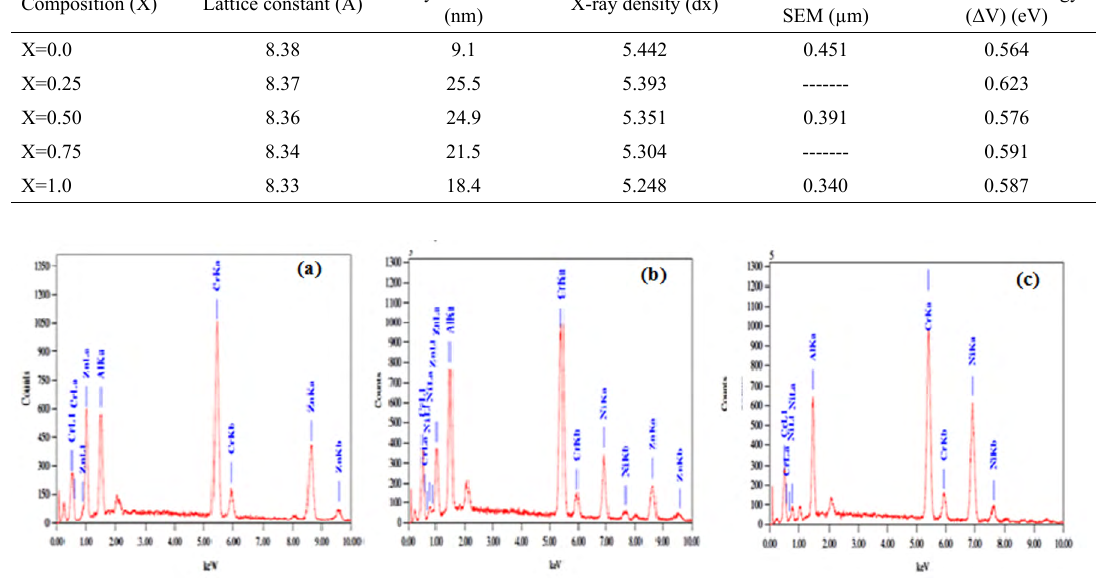
Ni AlCrO (X = 0.0, 0.50, 1.0) 1-x x 4